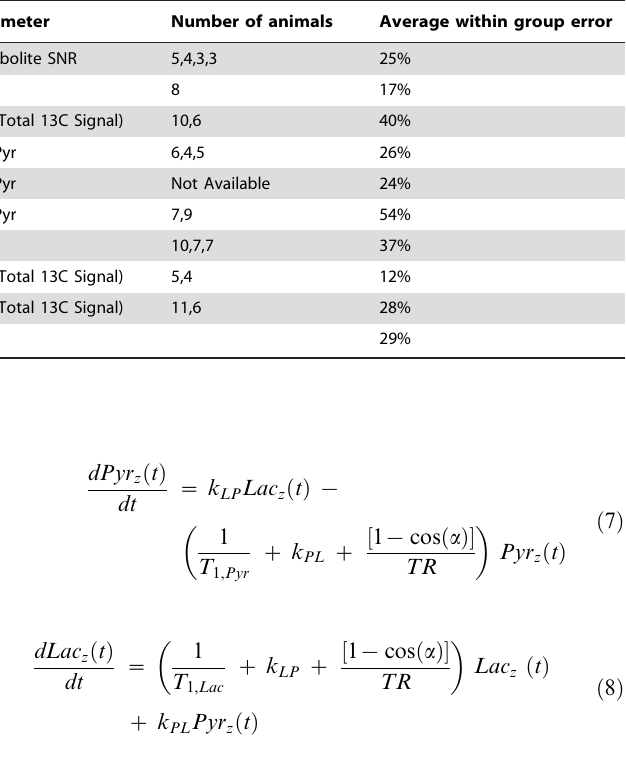
Reference Location Disease Parameter